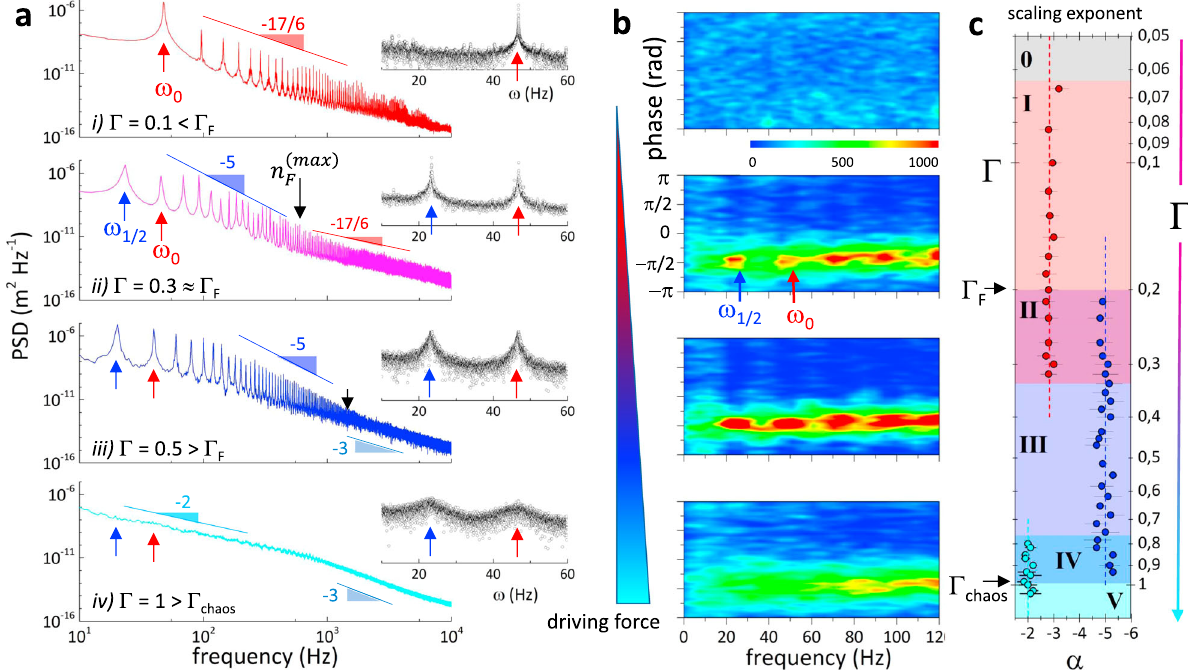
Fig. 2 Spectral power cascade and coherence of nonlinear surface waves. a Power spectral density (PSD) of the NLSWs excited at the air/water interface by vertically oscillating the vessel at frequency ω 0 = 47 Hz for increasing acceleration Γ ; from top to bottom: (i) Kolmogorov-Zakharov (KZ) spectrum of weak wave turbulence (at Γ < Γ F ) with ω − 17/6 -intensity decay typical of cascades of nonlinear capillary waves; (ii) hybrid spectrum of turbulence with superimposed subharmonic ω 1/2 (blue arrow), and fundamental ω 0 (red arrow) cascades (at Γ ≥ Γ F ). The Faraday ω − 5 -cascade predominates in the lower frequency range, while the ω − 17/6 -decay prevails at higher frequencies. (iii) Pure Faraday spectrum of inertia-controlled resonance with ω − 5 -envelope that ends into a terminal ω − 3 -tail (at Γ > Γ F ); (iv) chaotic continuous spectrum at crossover between Landau ’ s turbulence ~ ω − 2 , and terminal frictional death ~ ω − 3 (at Γ ≫ Γ F ). The insets highlight the spectral range of ω 0 and ω 1/2 in linear scale. Numerical simulations and theoretical interpretations of these spectra can be found in Supplementary Note 1. b Phase distribution of the spectra reported in ( a ) for increasing driving force (from red to blue). Phase locking between the cascade resonances is observed when ω 1/2 emerges. c Scaling exponent ( α ) that fi tted the peak cascades as a function of Γ , highlighting the transitions between the regimes described in ( a ); they are qualitatively delimitated by different color areas. The gray (0) area represents the linear regime; pink (I) area the ω − 17/6 KZ-decay; the purple (II) area the hybrid cascade (KZF); the dark blue (III) area the pure Faraday cascade ( ω − 5 ); the blue (IV) area the coexistence of Faraday and ω − 2 -decay cascades of Landau ’ s unsteadiness; fi nally, the light blue (V) area delimits the completely chaotic cascades. The error bars correspond to the fi t